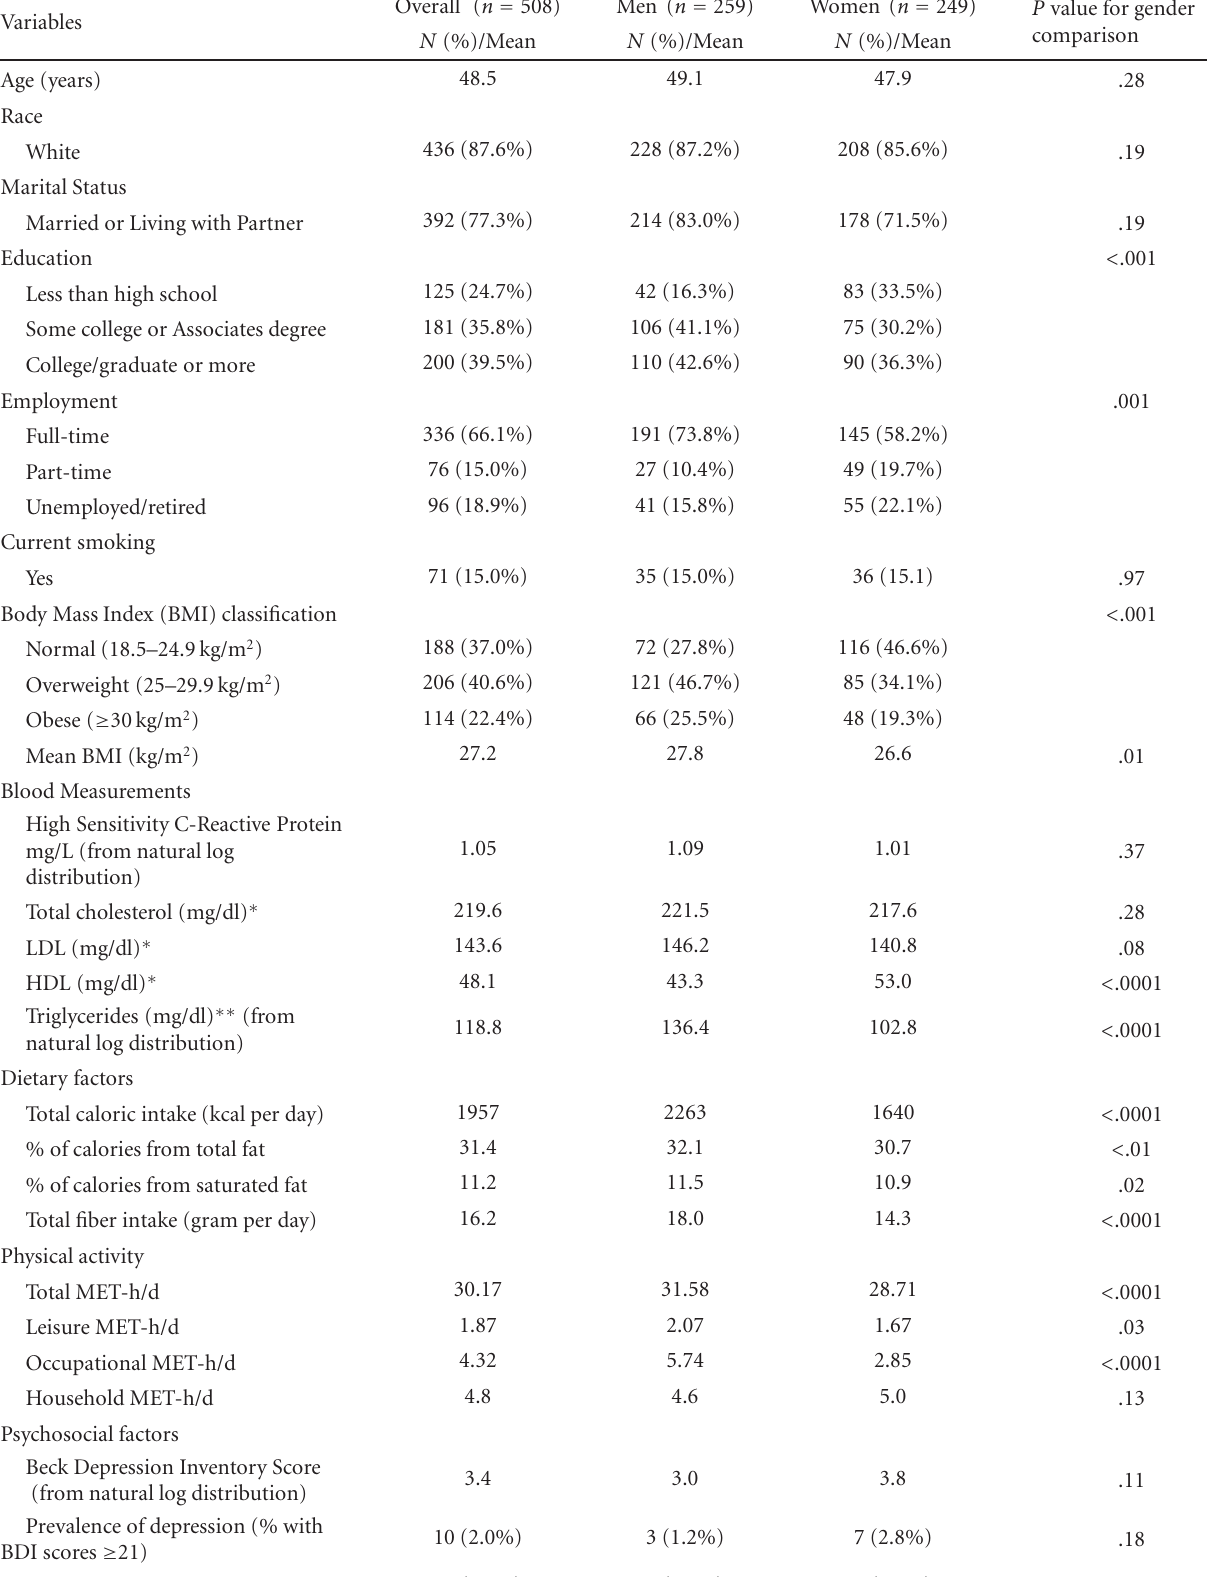
Table 1: Characteristics of study participants, overall and by gender, SEASONS study, Worcester, MA,